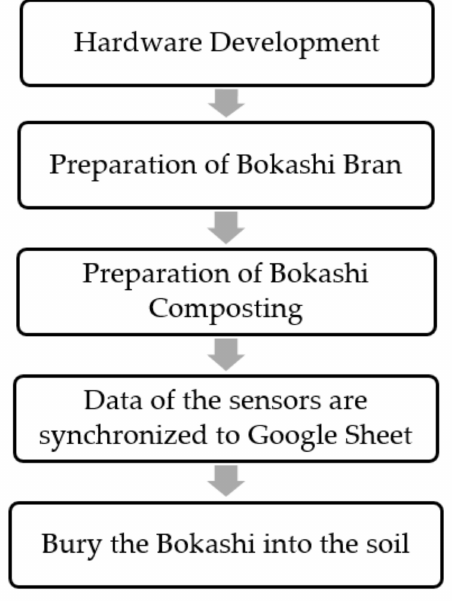
Figure 1. Overall process flow of this